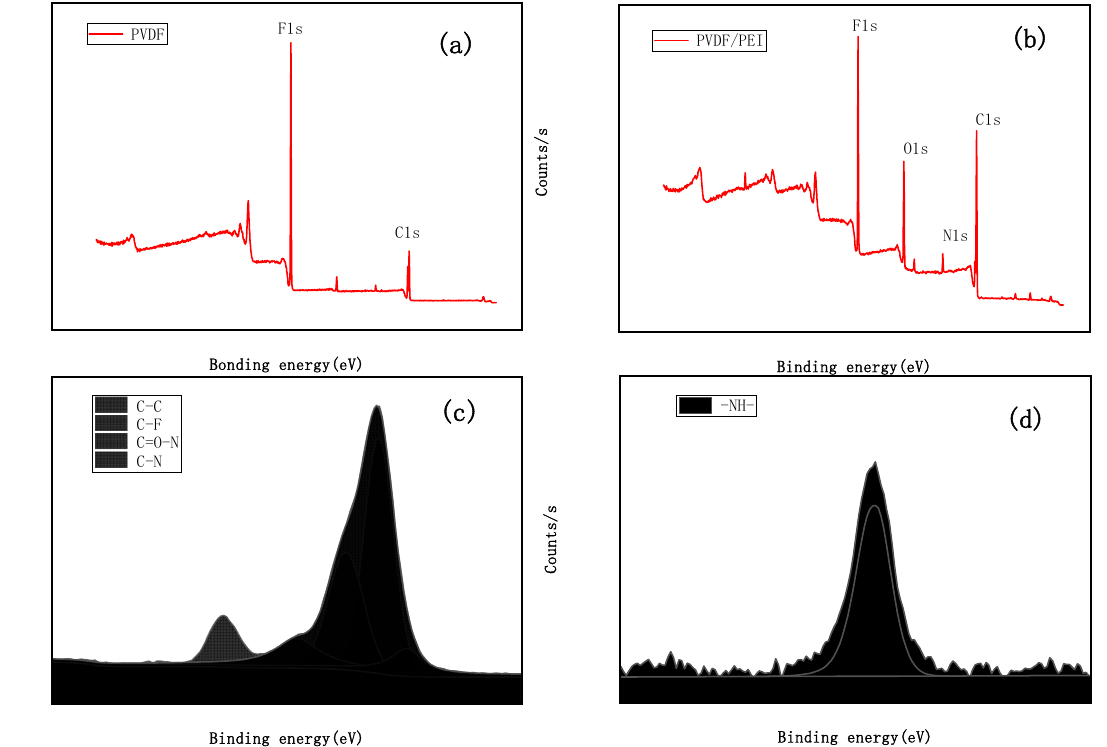
Figure 1. XPS spectrum of PVDF/PEI blend membrane. ( a ) Wide spectrum of PVDF pure membrane. ( b ) Wide spectrum of PVDF/PEI blend membrane. ( c ) C1s spectrum of PVDF/PEI blend membrane. ( d ) N1s spectrum of PVDF/PEI blend membrane. Table 2. XPS element content.